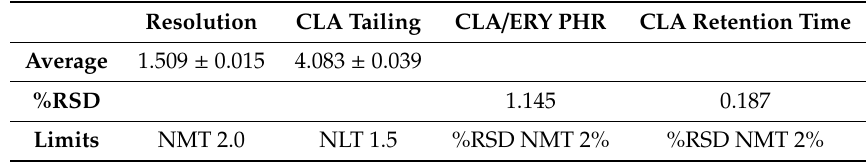
Table 8. USP scaling assay results for